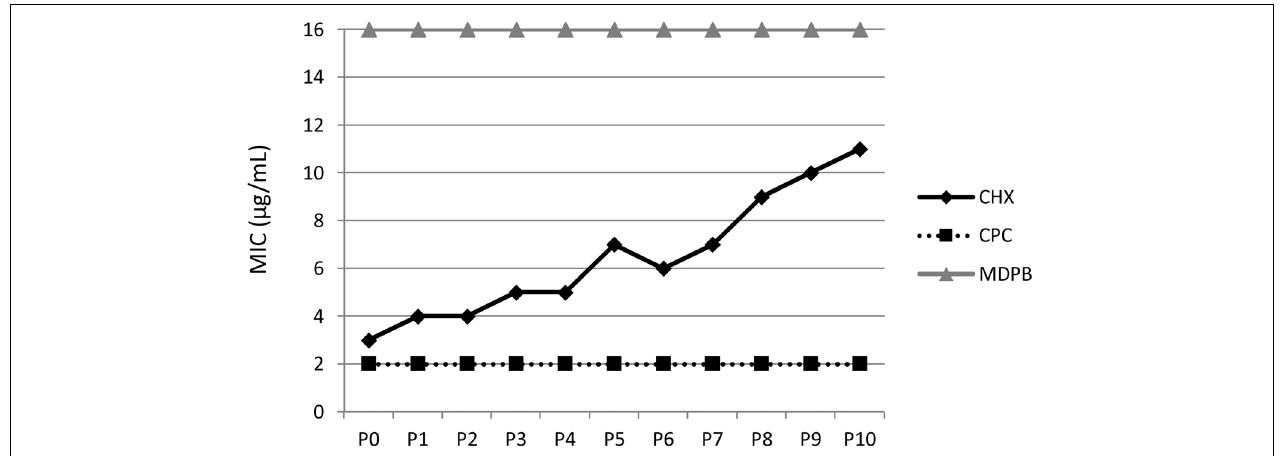
FIGURE 4 | Multiple passaging of bacteria under CHX-treatment in vitro . MICs of CHX, cetylpyridinium chloride (CPC) and methacryloyloxydodecylpyridinium bromide (MDPB) repeatedly performed from passages 0–10 (P0–P10) against E. faecalis . This figure is reprinted from Kitagawa et al. (2016) with kind permission from the